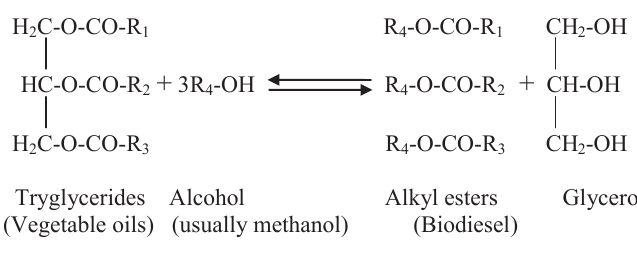
Fig. 1 – Transesterification of